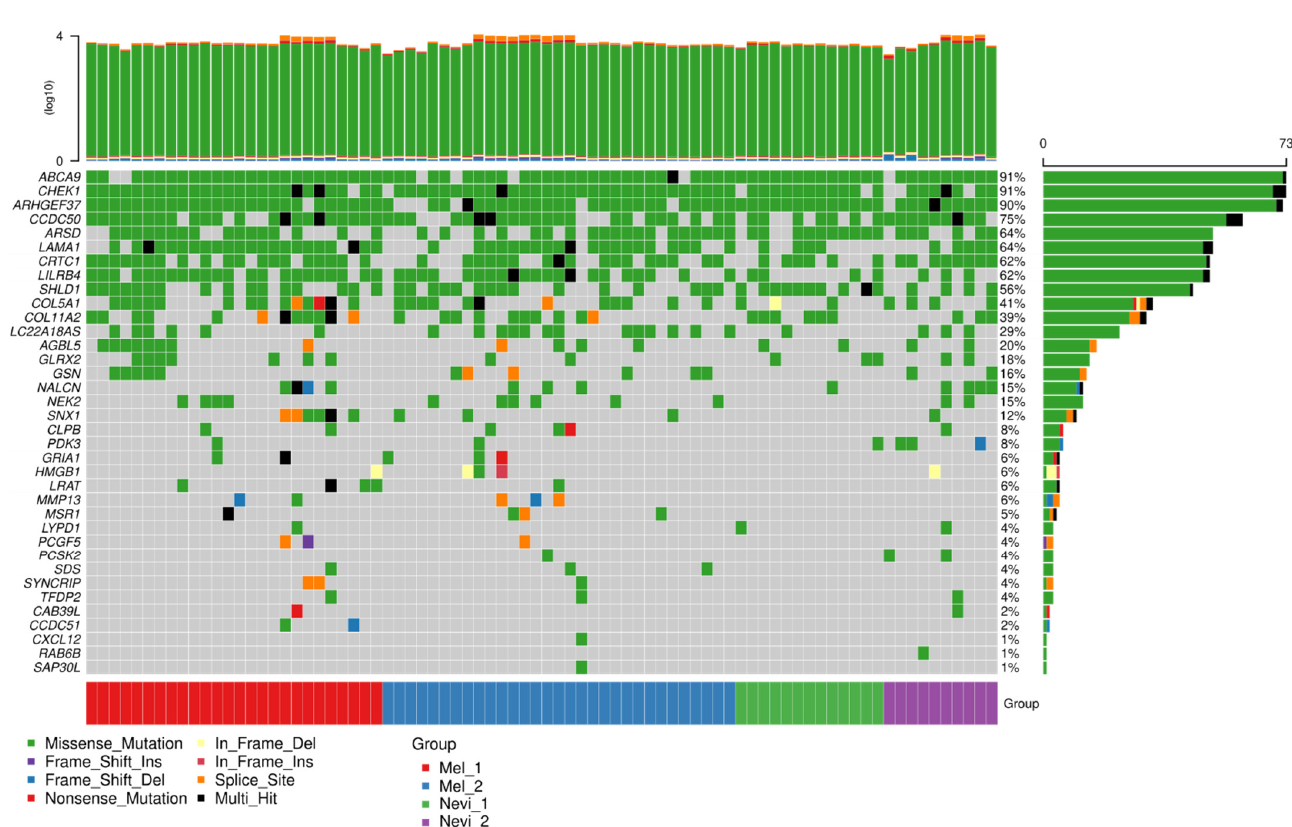
Figure 8. Mutational load of spliced genes in the comparison of primary melanomas against benign melanocytic nevi. A mutation analysis was performed from the basic set of samples sequenced by RNA-seq for coding regions of genes. Shown are the top spliced genes in the present study.